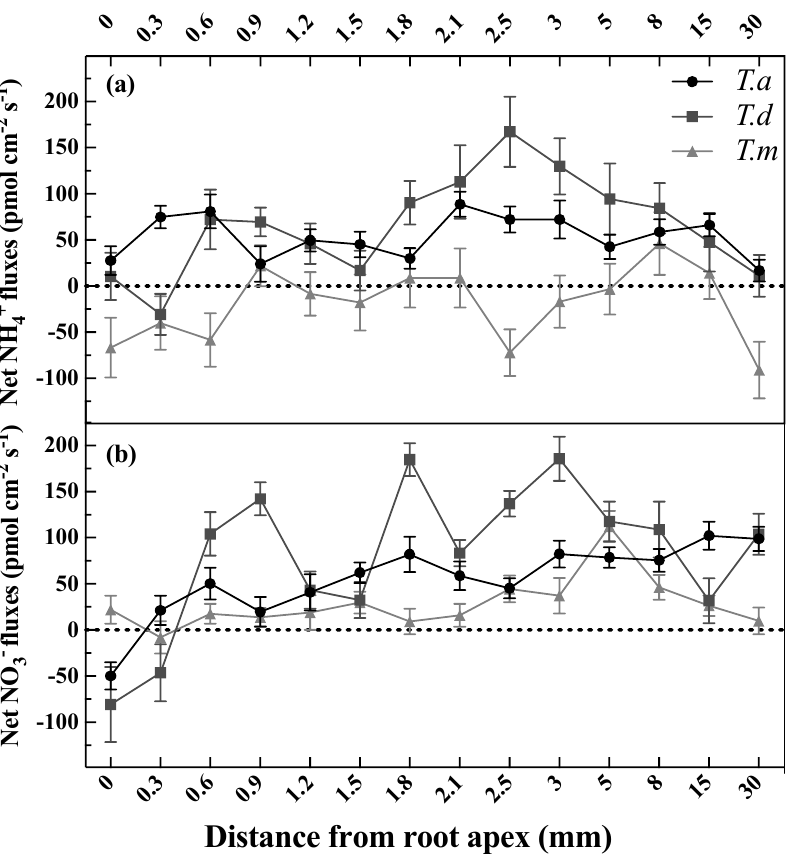
Figure 2. Net NH 4+ ( a ) and NO 3 − ( b ) fluxes along the root tip of T. ascendens , T. distichum , and T. mucronatum . Bars indicate standard errors ( n = 8). Net influxes correspond to positive values, and negative values indicate net effluxes, respectively. The concentrations of N were set as 1.0 mM NH 4 Cl for NH 4+ or 1.0 mM KNO 3 for NO 3 − . T. a , T. d , and T. m represent T. ascendens , T. distichum and T. mucronatum , respectively.